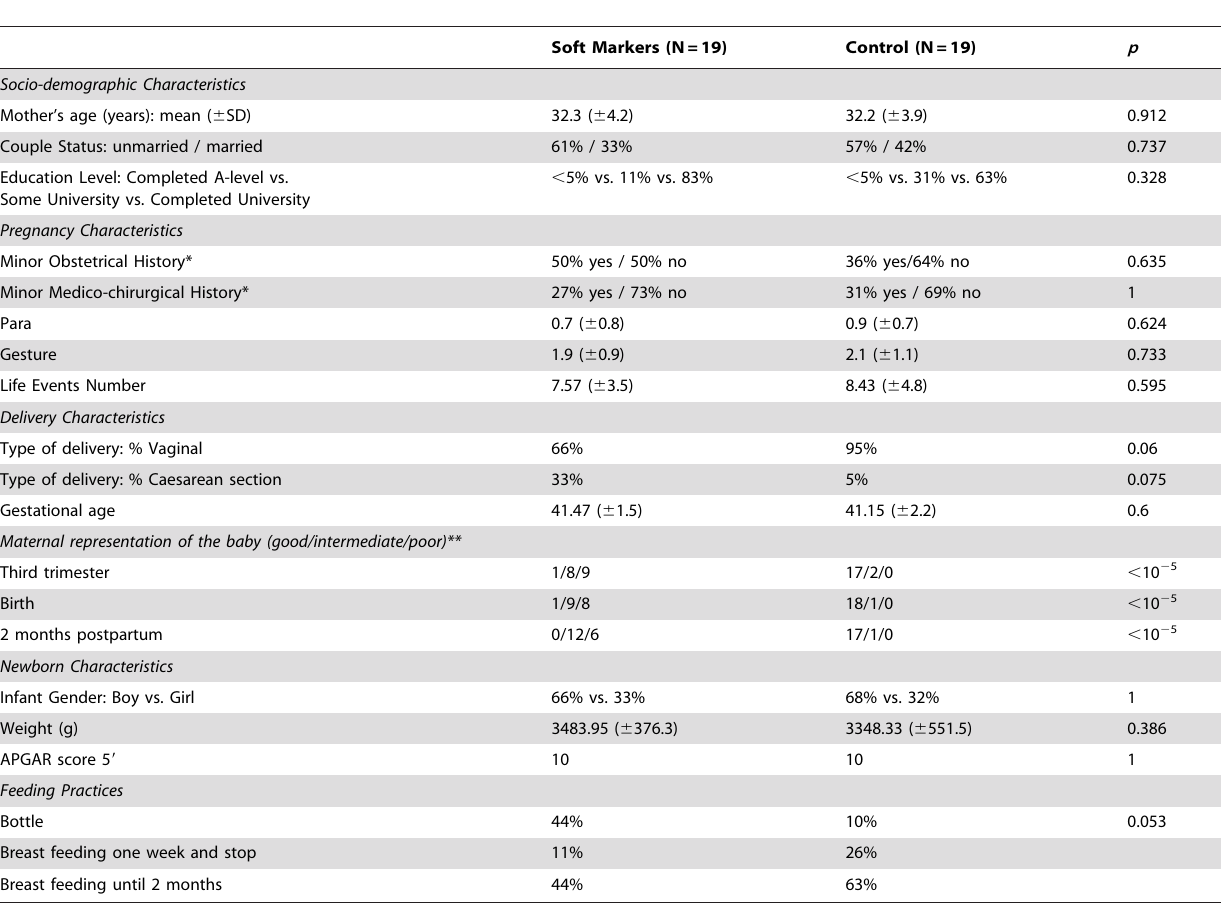
Table 1. Socio-demographic, pregnancy, delivery, newborn, and dyad characteristics according to scan soft markers or